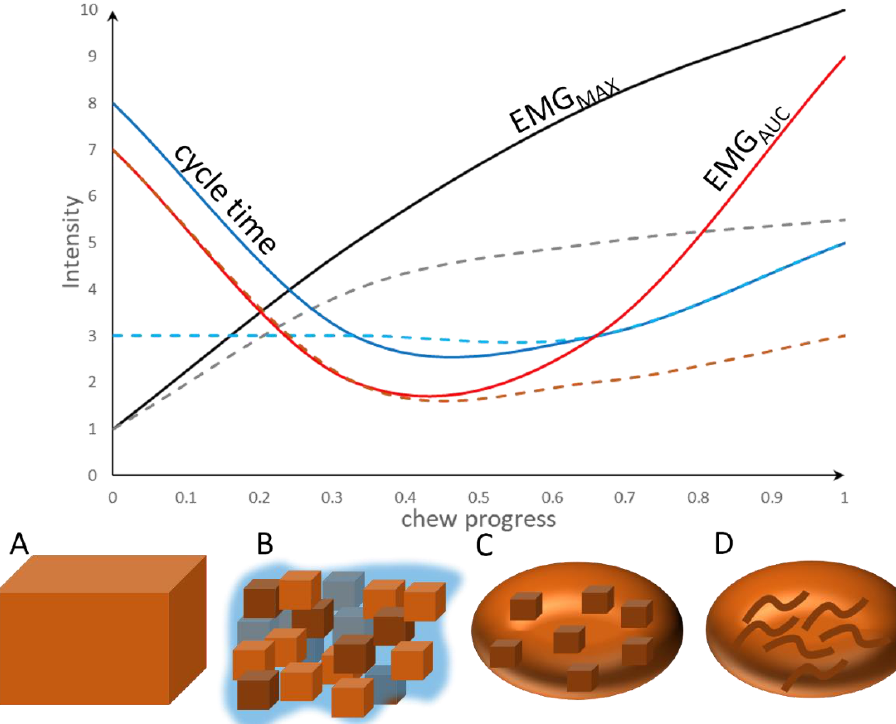
Figure 4. Schematic illustration of the food transition from a solid cube to a swallowable bolus during oral processing. Cycle time, maximal muscle activity-, and the integral of muscle activity per bite are shown for fully anisotropic ( – ) and isotropic samples (- -). ( A – D ) show a hypothesized structure of the matter during oral processing. Dark brown particles and fibrils illustrate structured- and softened meat particles, light brown matter displays meat batter.